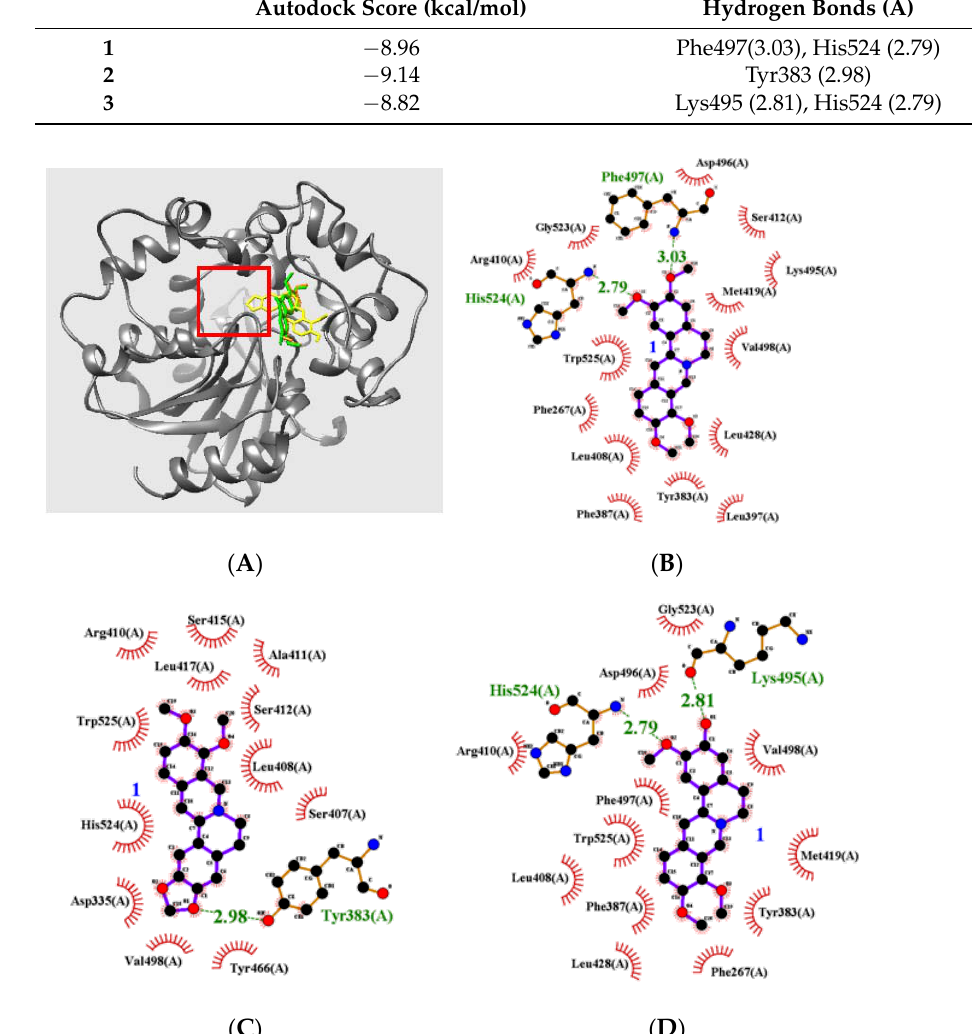
Figure 3. The binding pose ( A ) of three alkaloids 1 – 3 into sEH (red box: active site). Hydrogen bond interactions of inhibitors with the enzyme ( B – D ). Table 2. Interaction of quaternary isoquinoline alkaloids 1–3 and autodock score for sEH